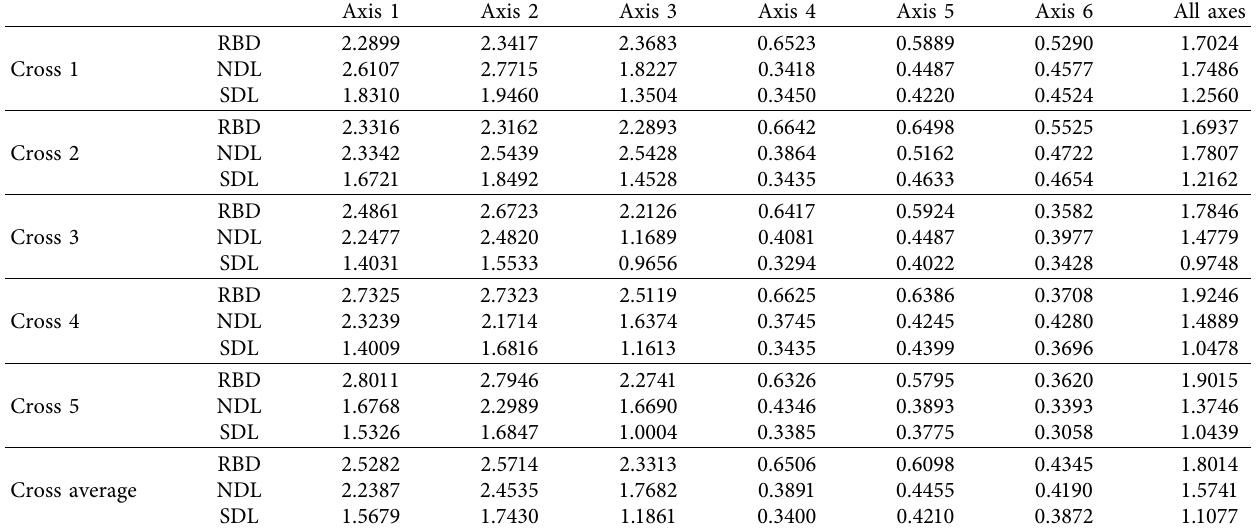
Table 2: Prediction results of RBD, NDL, and SDL